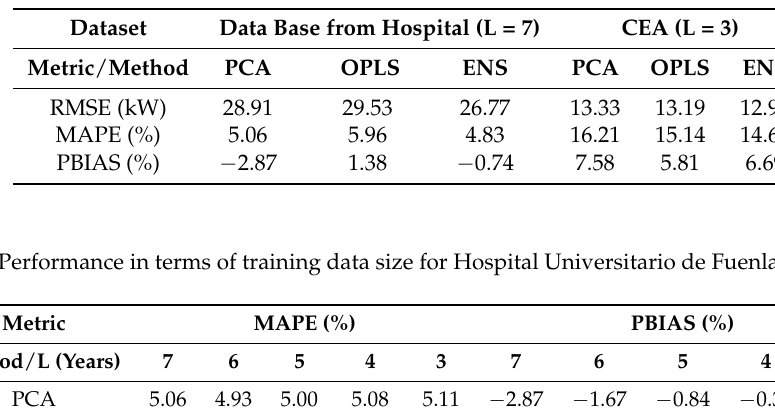
Table 2. Performance metric calculation.